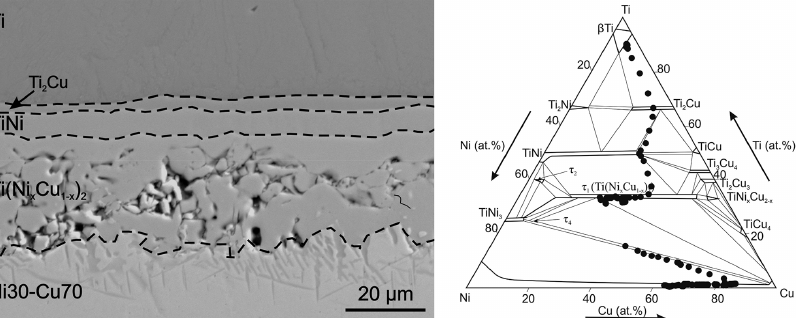
Figure 2: Left – the microphotography showing grown intermetallic phases, right – the diffusion path in diffusion couple experiment Ti-Ni30Cu70 at 1,123 K after 160